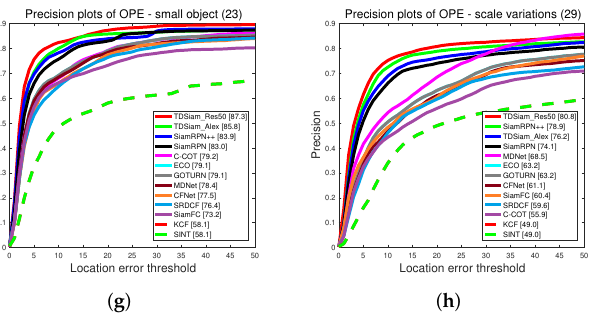
Figure 13. Precision plots corresponding to some different scenarios. The UAVDT dataset was used for the evaluation. ( a ) Background Clutter; ( b ) Camera Motion; ( c ) Illumination Variations; ( d ) Large Occlusion; ( e ) Object Blur; ( f ) Object Motion; ( g ) Small Object; ( h ) Scale Variations.